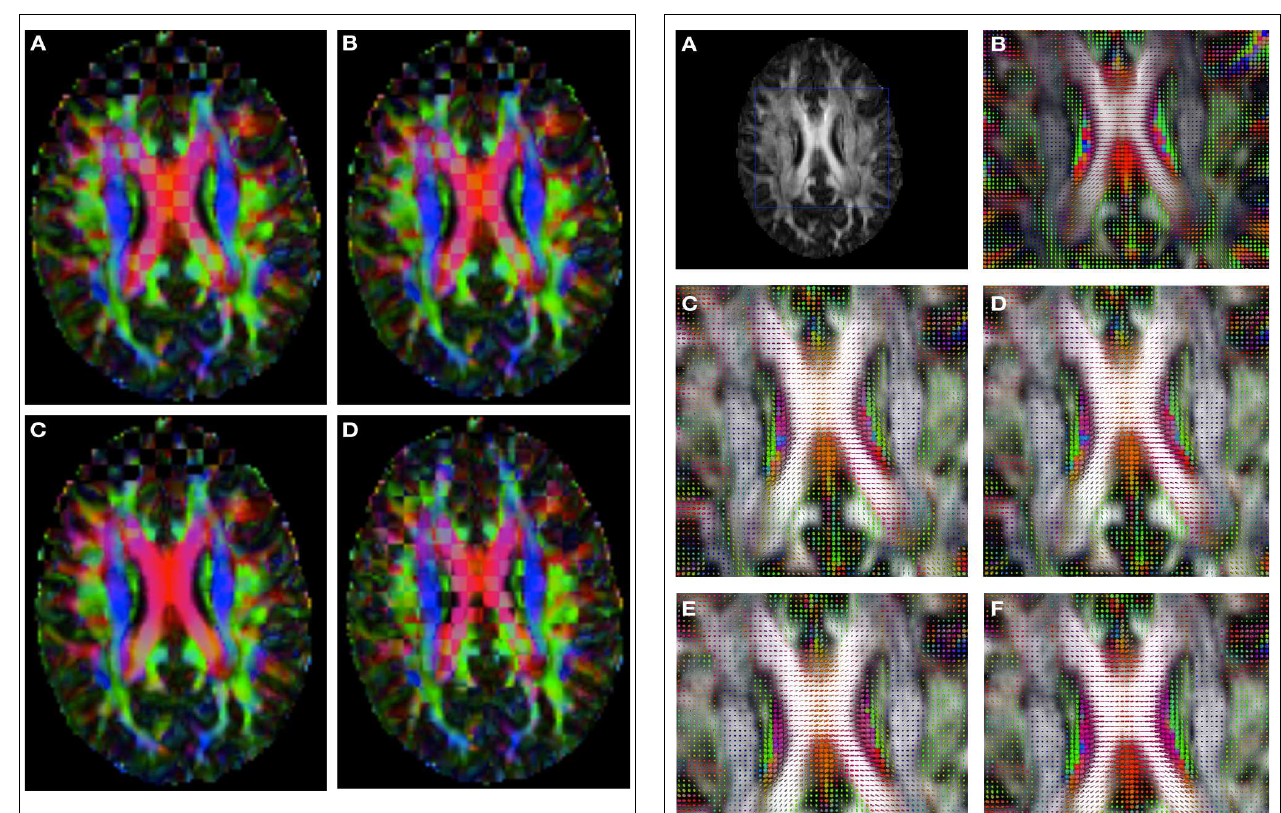
FIGURE 2 | Checkerboard comparison of the RGB color coded main diffusion direction between Subject2 and a registered random affine transformation of Subject2 using (A) FLIRT-volumes-SH. (B) FLIRT4D-AI. (C) MedINRIA-volumes-SH, (D) DTI-TK-volumes-SH. their corresponding standard deviation, except for the two 3T datasets, where only the mean is reported.